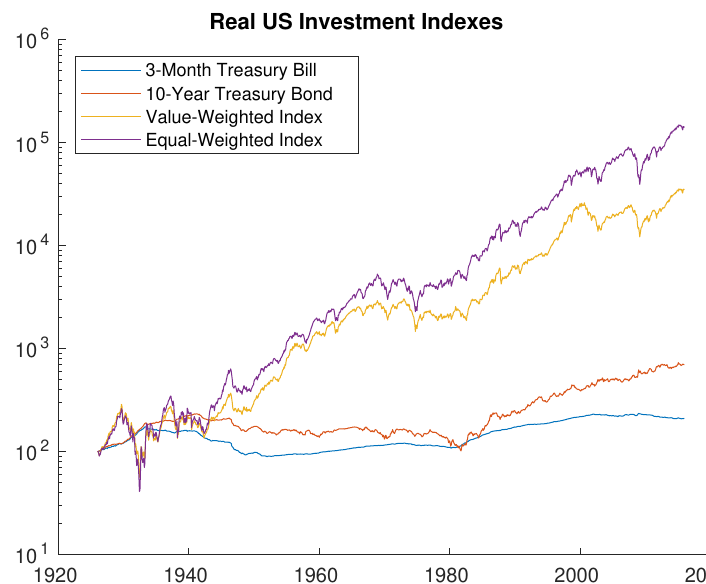
Figure 2. Cumulative real returns for US investment indexes,